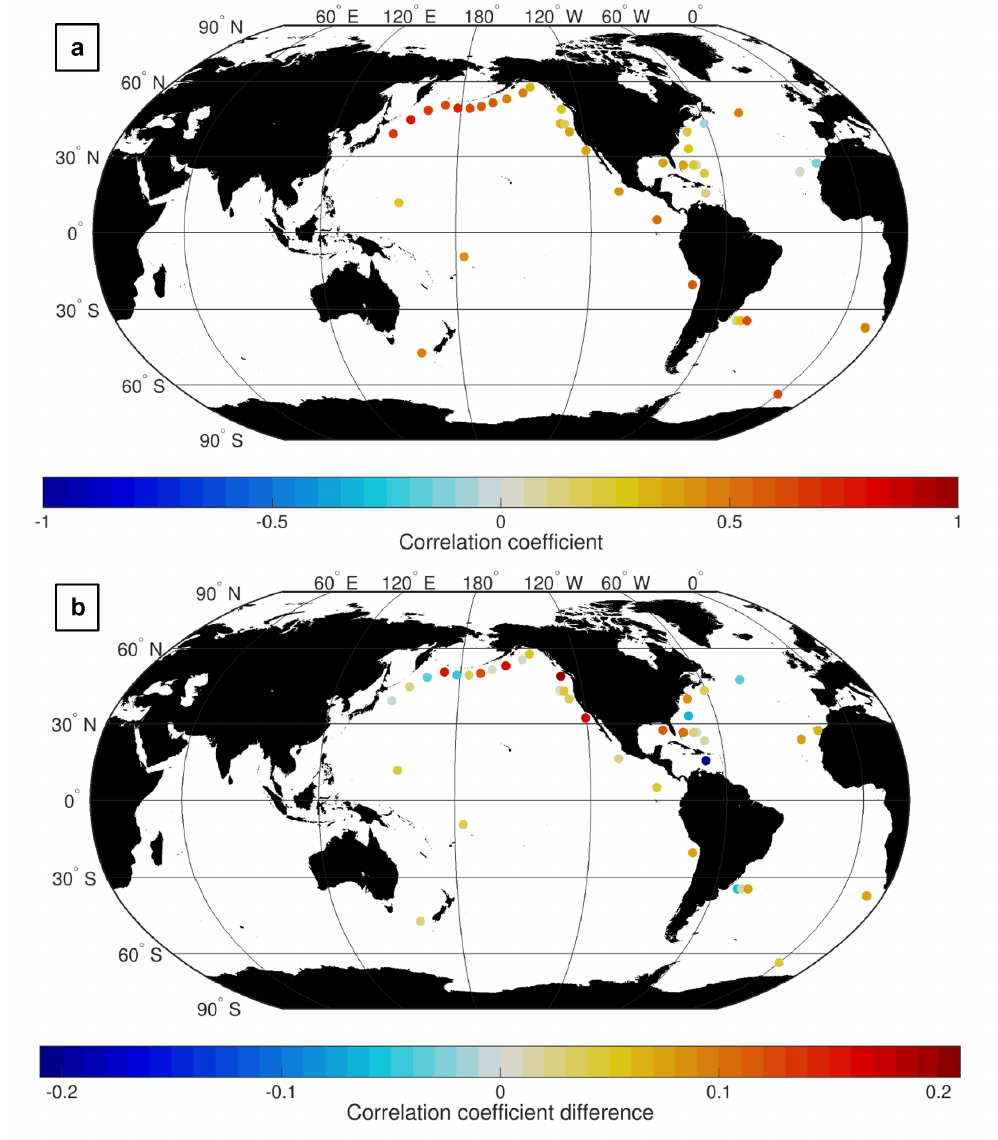
Figure 4. ( a ) Correlation coefficient of depth-adjusted downscaled GRACE with in situ BPR time series, 3–12 month timescales. ( b ) Correlation coefficient difference between depth-adjusted down- scaled GRACE correlations in ( a ), minus the correlations of not-downscaled GRACE with in situ BPR time